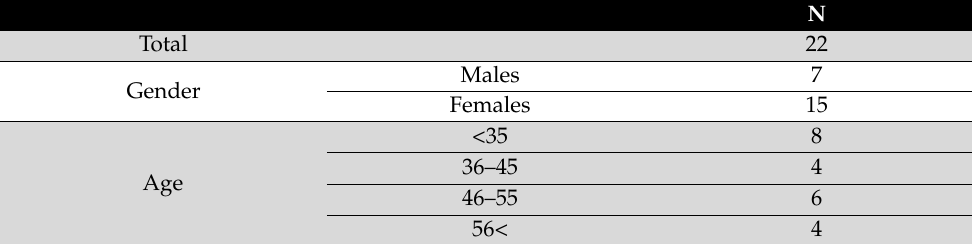
Table 2. Participant data from Kaplan Medical